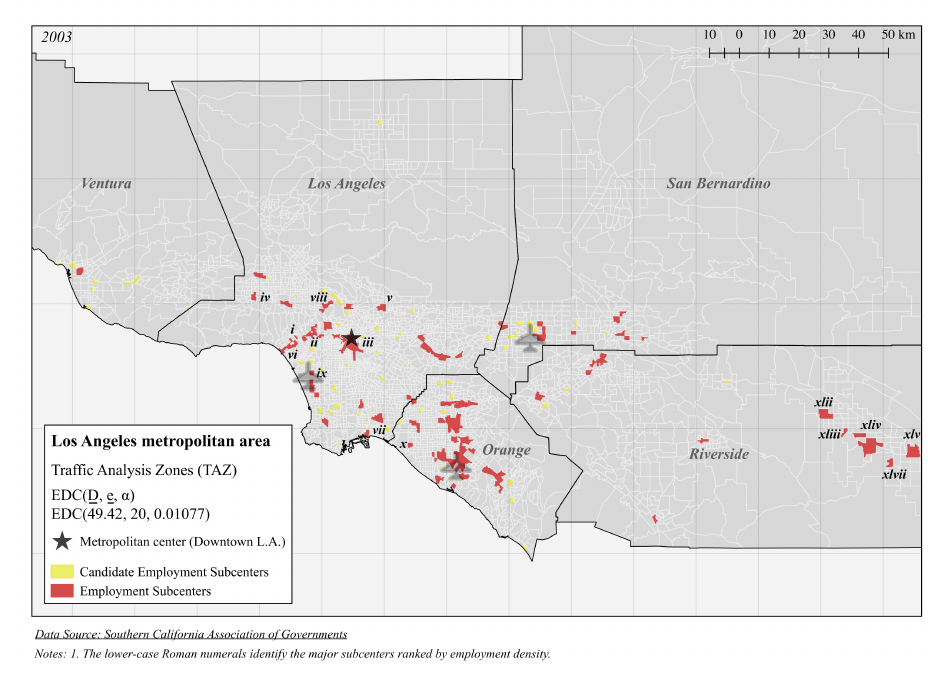
Figure 3. Los Angeles metropolitan area subcenters identified by EDC(49.42, 20;